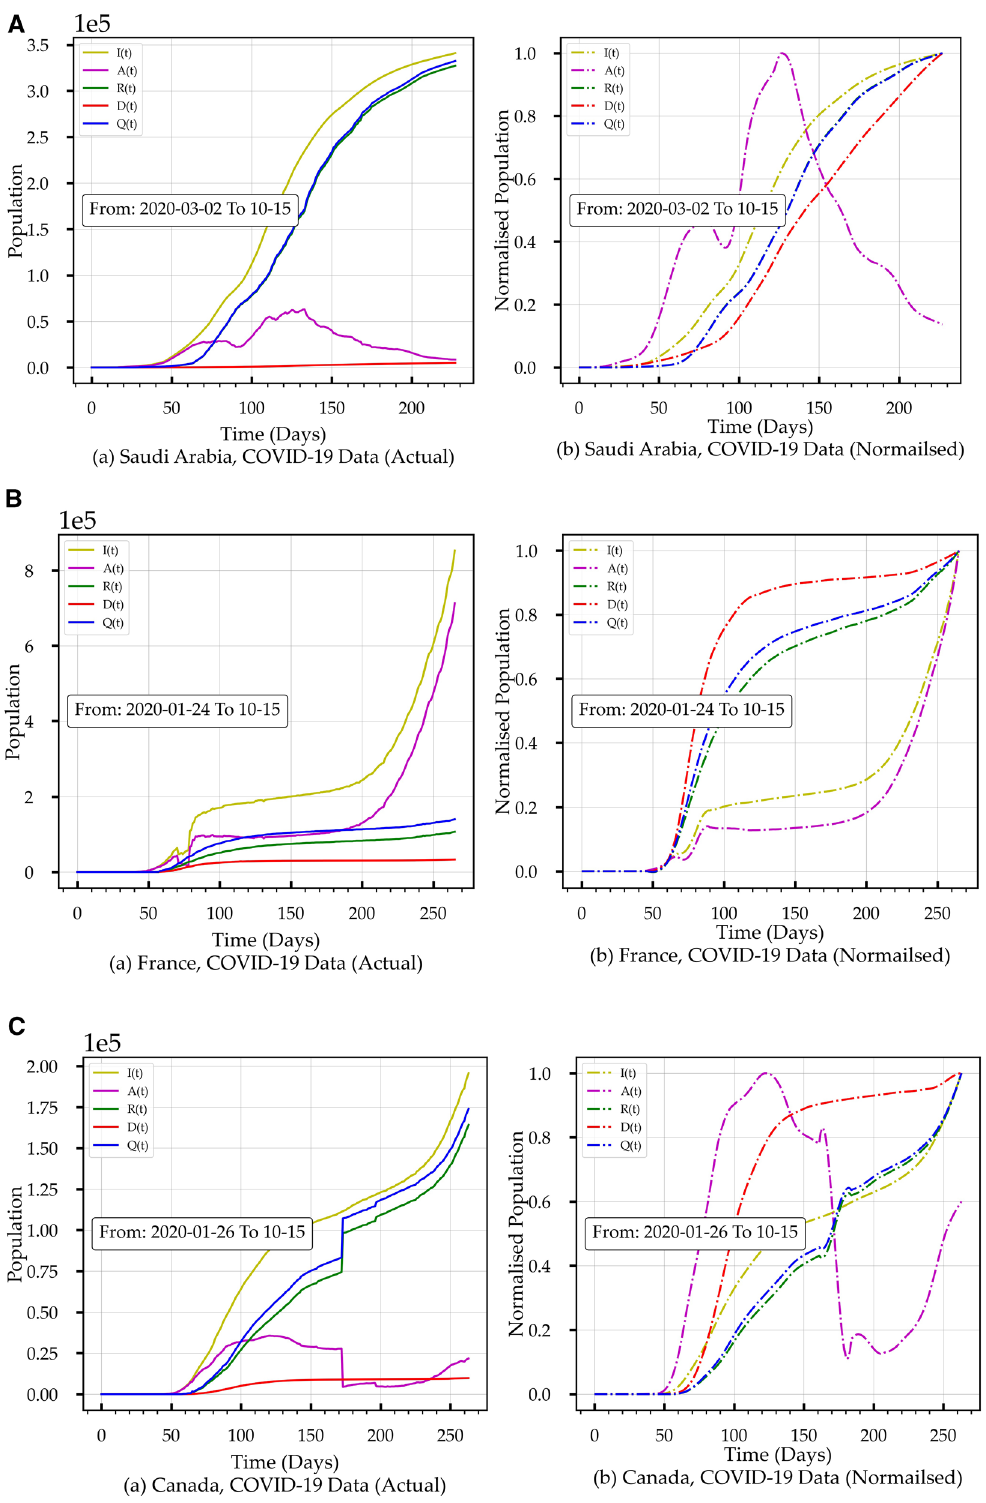
Figure 2. ( A ) Two versions of the COVID-19 published data with the end date of October 15th, 2020 for Saudi Arabia. ( a ) the actual uploaded data. ( b ) the normalised versions of the data. ( B ) Two versions of the COVID- 19 published data with the end date of October 15th, 2020, for France. ( a ) the actual uploaded data. ( b ) the normalised version of the data. ( C ) Two versions of the COVID-19 published data with the end date of October 15th, 2020 for Canada. ( a ) the actual uploaded data. ( b ) the normalised version of the